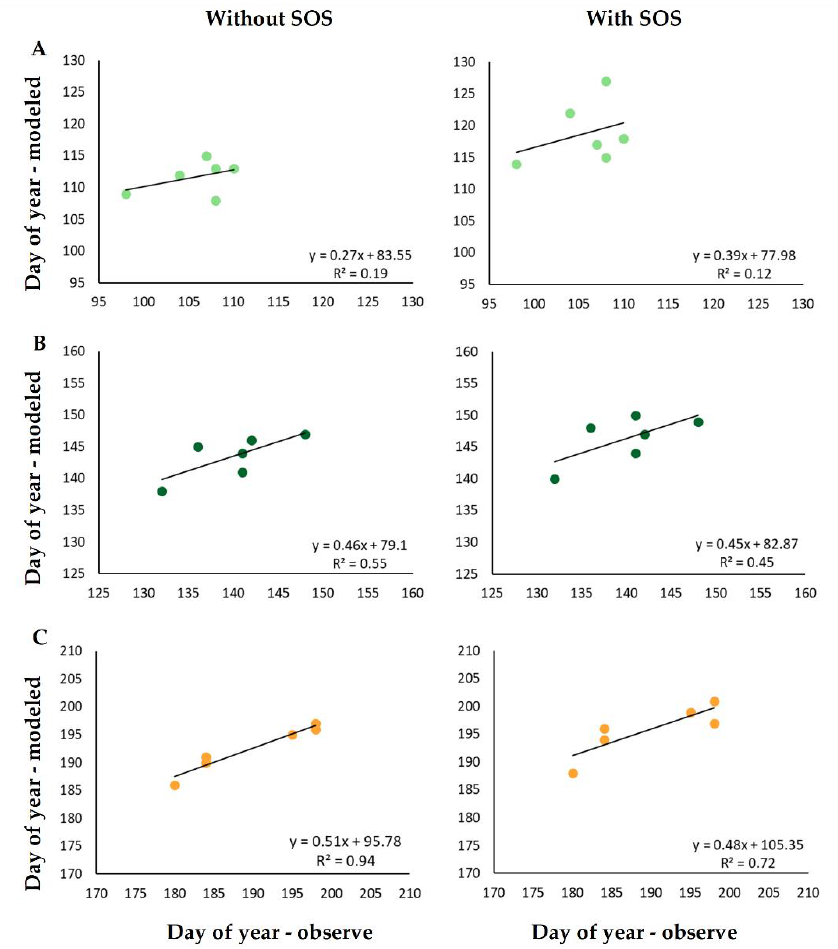
Figure 3. Comparison between observed and modeled values excluding the start of the season (left side) and a comparison between the observed and modeled values including the start of the season based on a Z-score being 0 (right side) for the jointing ( A ), heading ( B ), and full ripeness ( C ) phenotypes at Chrlice station in the time period from 2015 to 2020.